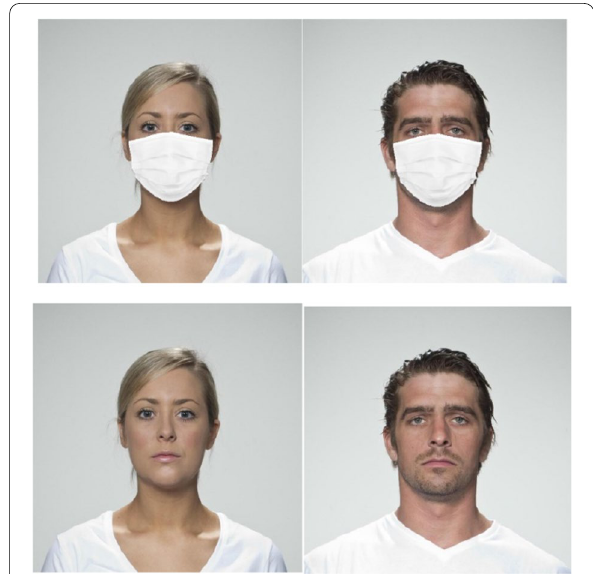
Fig. 1 Examples of the Materials used in all Experiments. Note. Full face stimuli were extracted from the Face Research Lab London Set (DeBruine & Jones, 2017) Face masking was implemented using the OpenCV v3.4.2 and dlib v19.19 modules within a Python 3.7